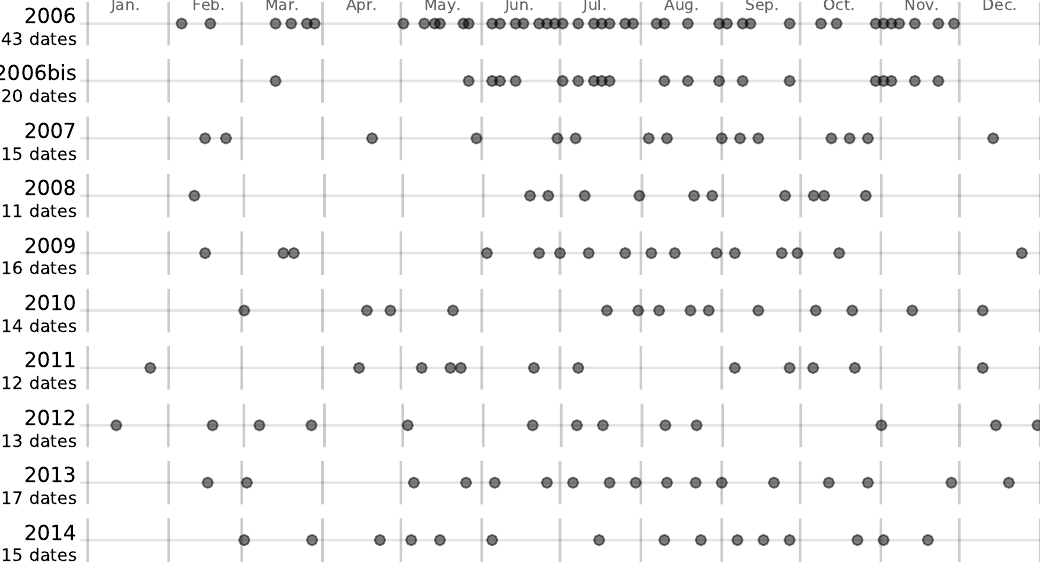
Figure 2. Number and acquisition dates of each image in the Formosat-2 time series from 2006 to